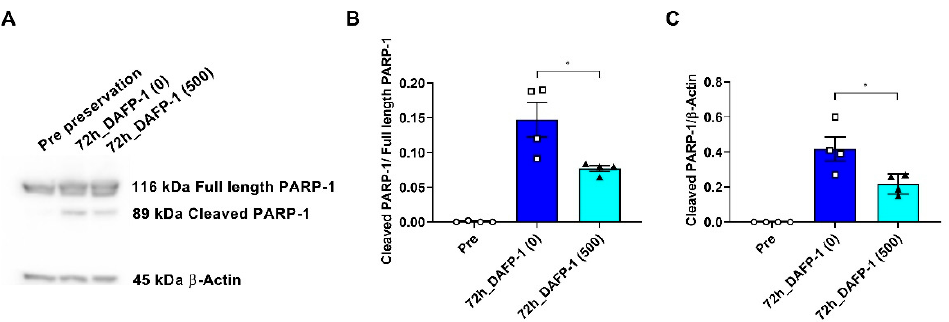
Figure 3. Fragments of poly(ADP-ribose) polymerase-1 (PARP-1) in the cold-preserved INS-1 cells. The total length and cleaved PARP-1 protein expressions in the INS-1 cells before and after 72 h of cold preservation with or without 500 µg/mL DAFP-1 were assessed by Western blot. ( A ) Repre- sentative image of the Western blot bands for the total length PARP-1, cleaved PARP-1, and β -actin, ( B ) quantified relative protein expression levels for the cleaved PARP-1 over β -actin, and ( C ) cleaved PARP-1 over total length PARP-1 (open circle for pre preservation, open square for 0 µg/mL, and solid triangle for 500 µg/mL DAFP-1). The data show the mean ± standard error of five independent experiments, * p < 0.05 by the Student t -test.